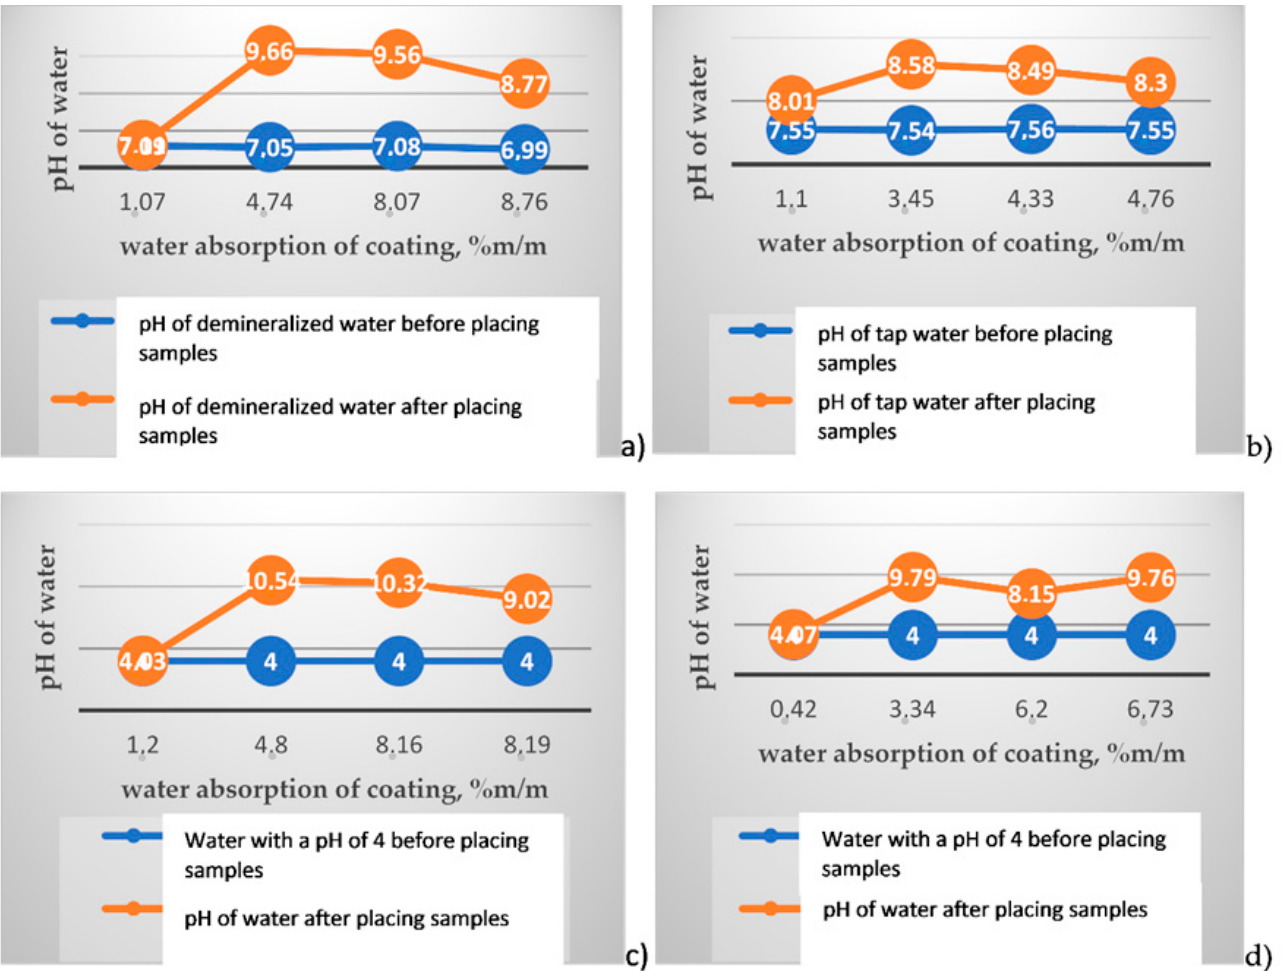
Figure 4. Comparison of water pH values after the test with water pH values before placing the samples in water. ( a ) for demineralized water, ( b ) for tap water, ( c ) for water with a pH of 4 and with the samples whose cut edges were not protected, ( d ) for water with a pH of 4 and with the samples whose cut edges were protected.